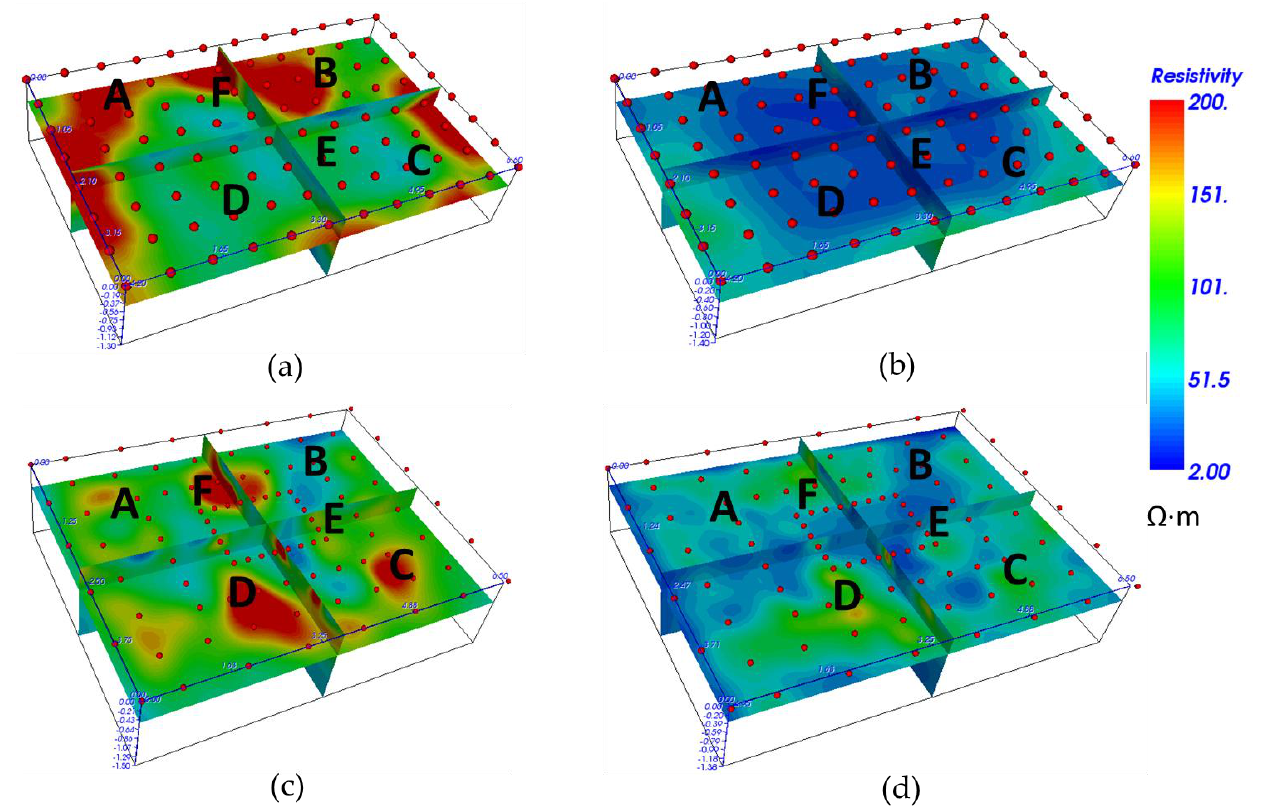
Figure 9. 3D ERTs acquired with the classical dipolar approach (upper figure) and loop – loop array (lower figure) in WL3 ( a , c ) and WL2 ( b , d ), respectvely. The cross section between the horizontal slices and the vertical ones is 0.5 cm.